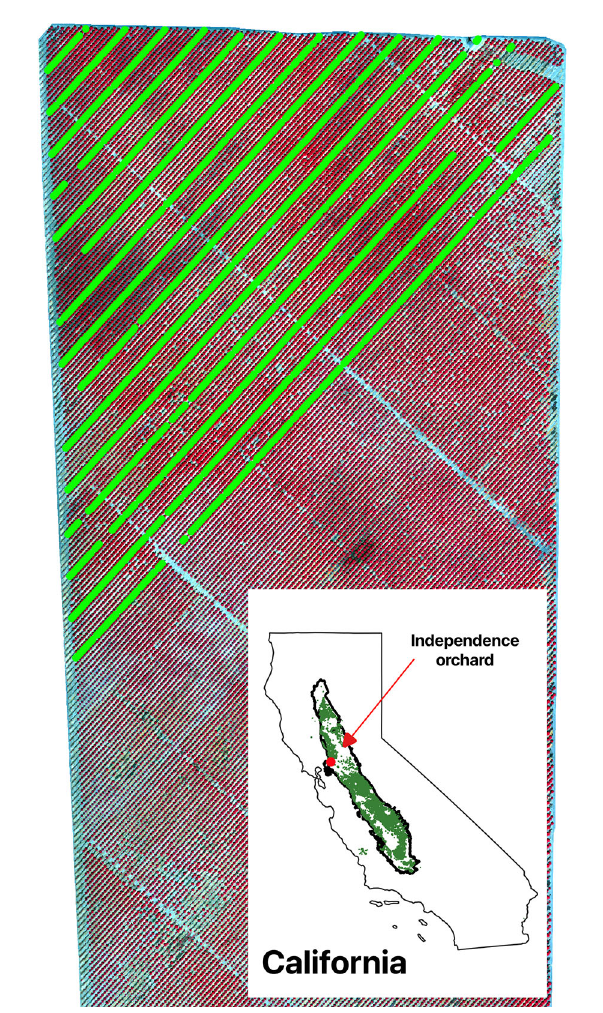
FIGURE 1 Study orchard as shown by the color infrared composite of CERES aerial imagery acquired on July 29, 2021. Individual trees with yield measurements were shown as green dots. The inset shows the location of the study orchard among all almond orchard fi elds (green) in California ’ s Central Valley (black